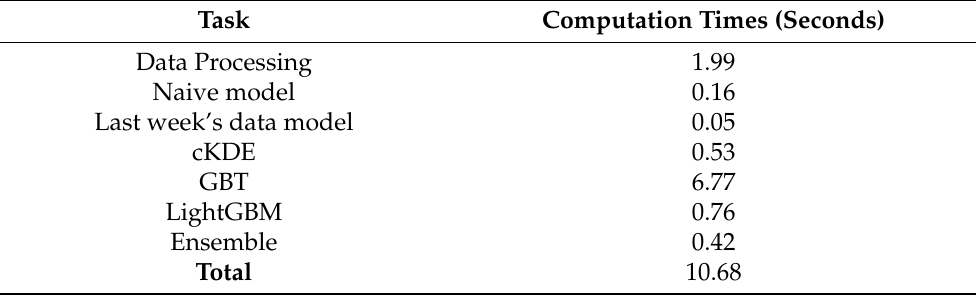
Table 3. Computational times for a load forecast run considering one year of historical data.